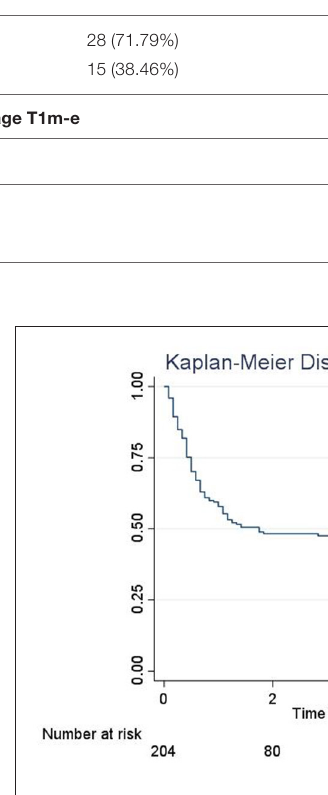
FIGURE 1 | Recurrence-free survival,